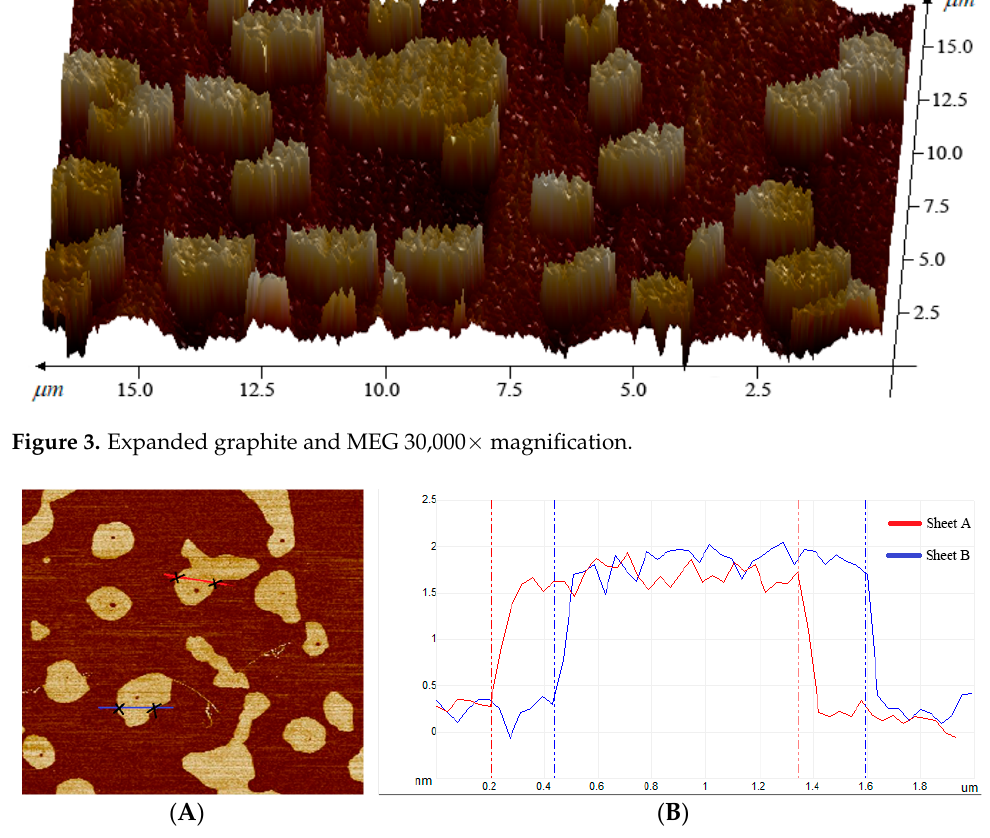
Figure 4. MEG sample cross ‐ sectional scan waveform. ( A ) Cross ‐ sectional selection; ( B ) Cross ‐ sectional waveform.